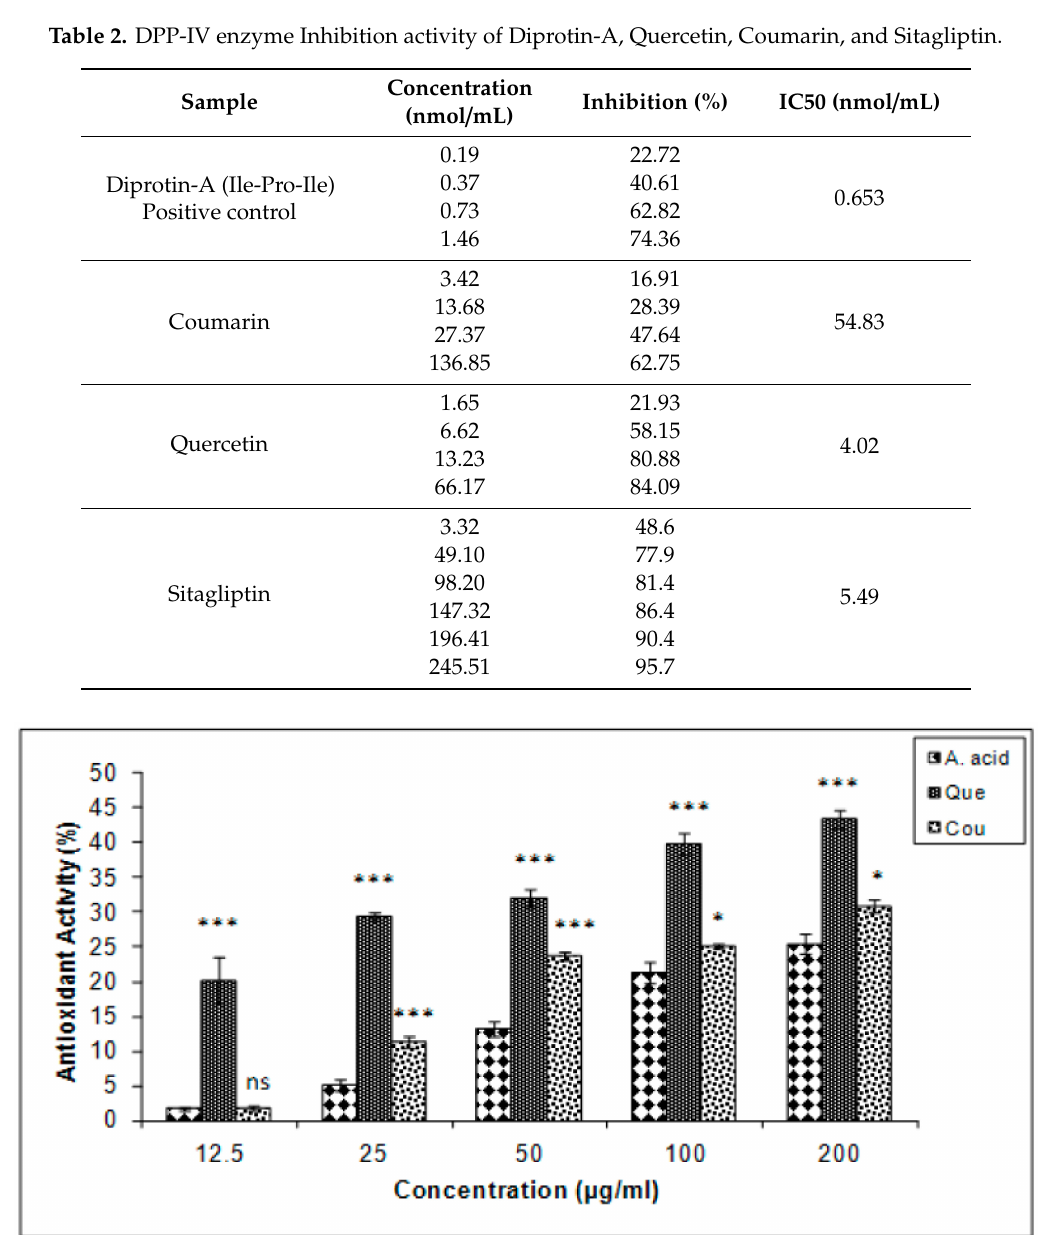
Figure 5. β carotene bleaching inhibition (%) in quercetin and coumarin as compared to the control; ascorbic acid. Each vertical bar represents the mean ± S.E.M. (n = 3), *** p < 0.001, ** p < 0.01 and * p < 0.05 as compared to the respective control values. A. acid, ascorbic acid; Que, quercetin; Cou,